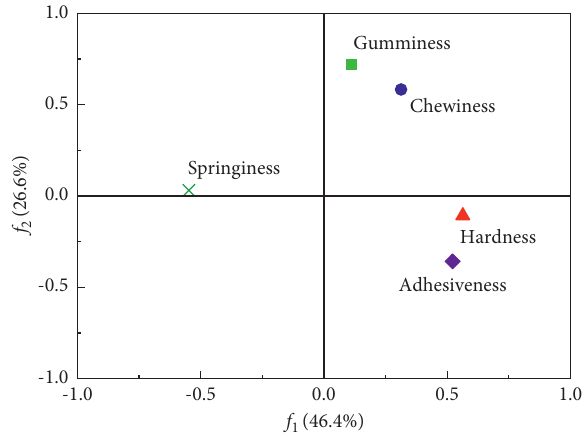
Figure 2: Biplot of the principal component analysis for sensory Table 5: Pearson correlation coefficients between the indexes of TPA and sensory evaluation.